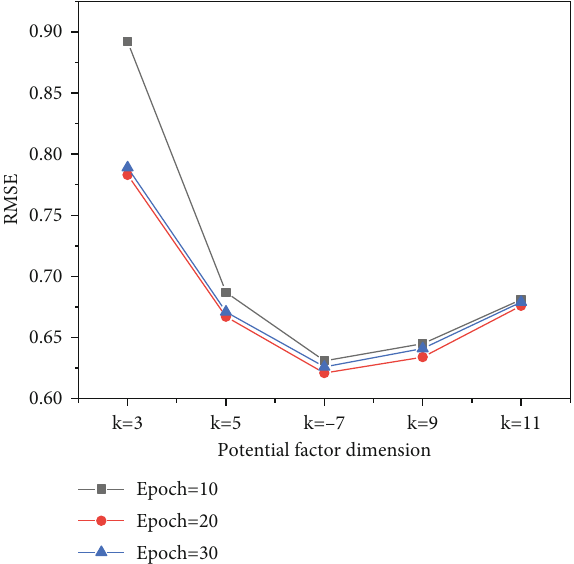
Figure 16: Model training prediction score for RMSE.